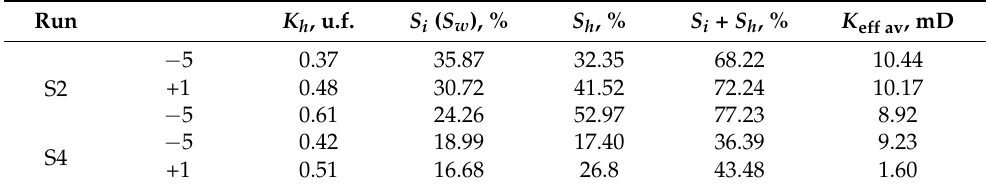
Table 4. Parameters of frozen hydrate-rich sand thawed and refrozen under the conditions of hydrate